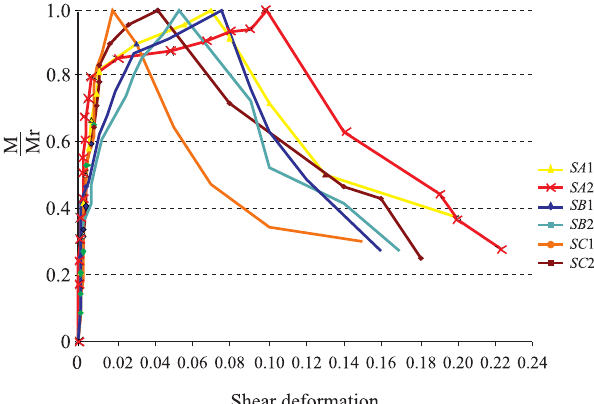
Fig. 9. Experimental shear deformation of the connections of composite